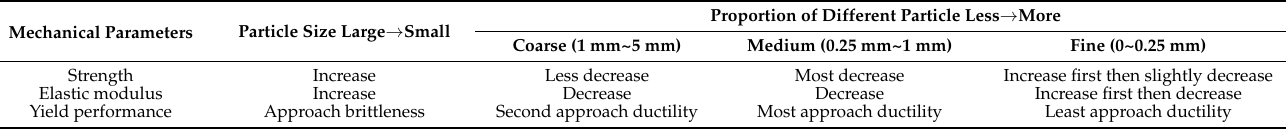
Table 4. Changes in the mechanical parameters of tectonic coal samples with different particle sizes. Mechanical Parameters